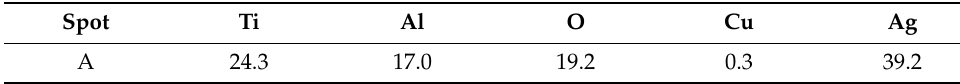
Figure 10. Microstructure of joints at different brazing temperatures for 20 min: ( a ) 970 °C, ( b ) 1000 °C, ( c ) 1020 °C, ( d ) 1050 °C and the enlarged image of ( a – d ): ( e ) 970 °C, ( f ) 1000 °C, ( g ) 1020 °C, ( h ) 1050 °C. Table 5. EDS result of each spot in Figure 10h (at. %).